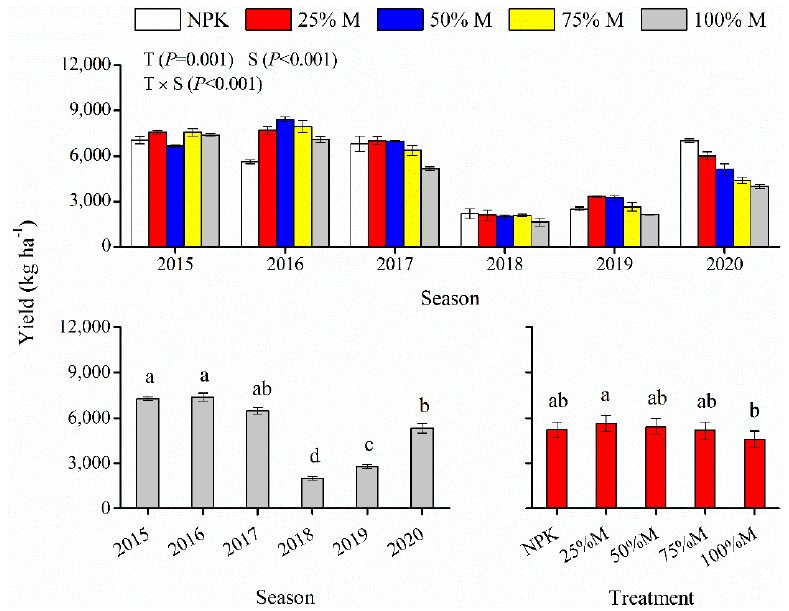
Figure 2. Wheat grain yield under different treatments of winter wheat–summer maize cropping system during 2014–2020. Bars represent standard error. Different letters above bars are significantly different between treatments or years at P < 0.05.